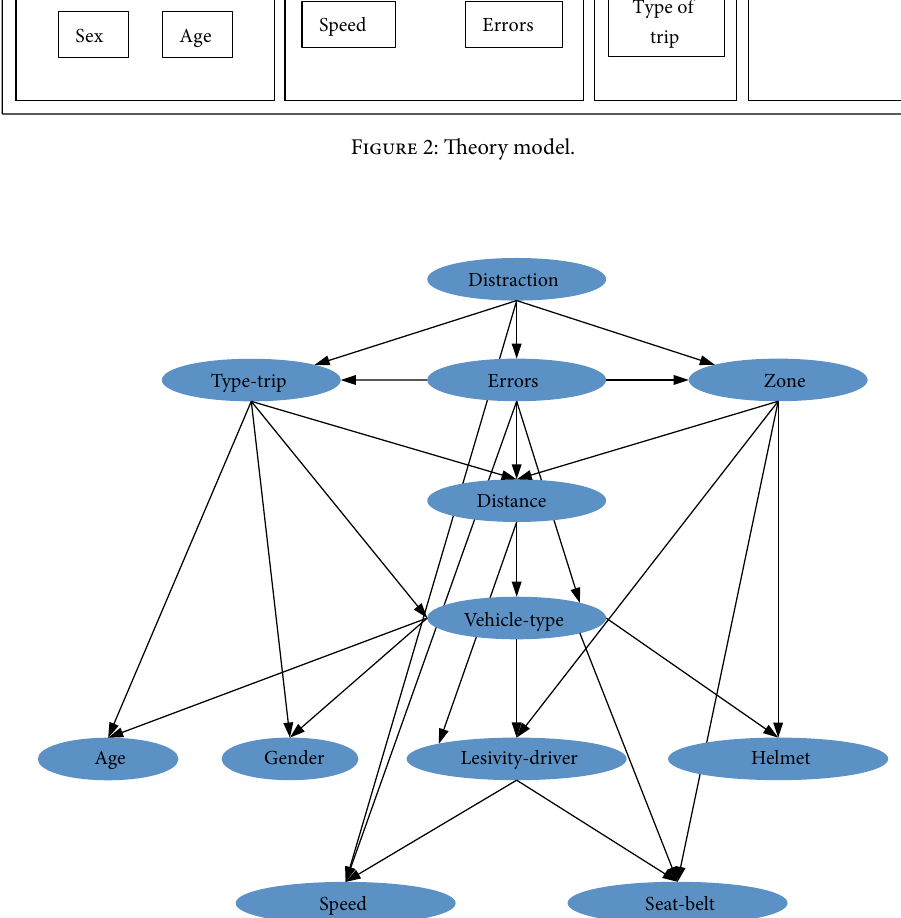
Figure 3: Bayesian network. Processed by the